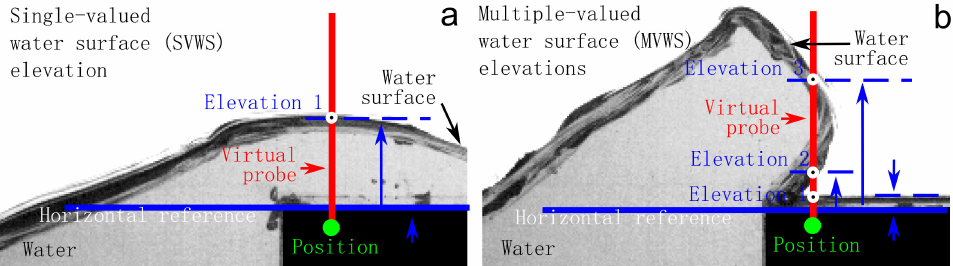
Figure 1. Definition of water surface measurements at a specific location over a horizontal domain. ( a ) Single-valued water surface (SVWS) elevation. ( b ) Multiple-valued water surface (MVWS) elevations. Images were modified from the database provided by